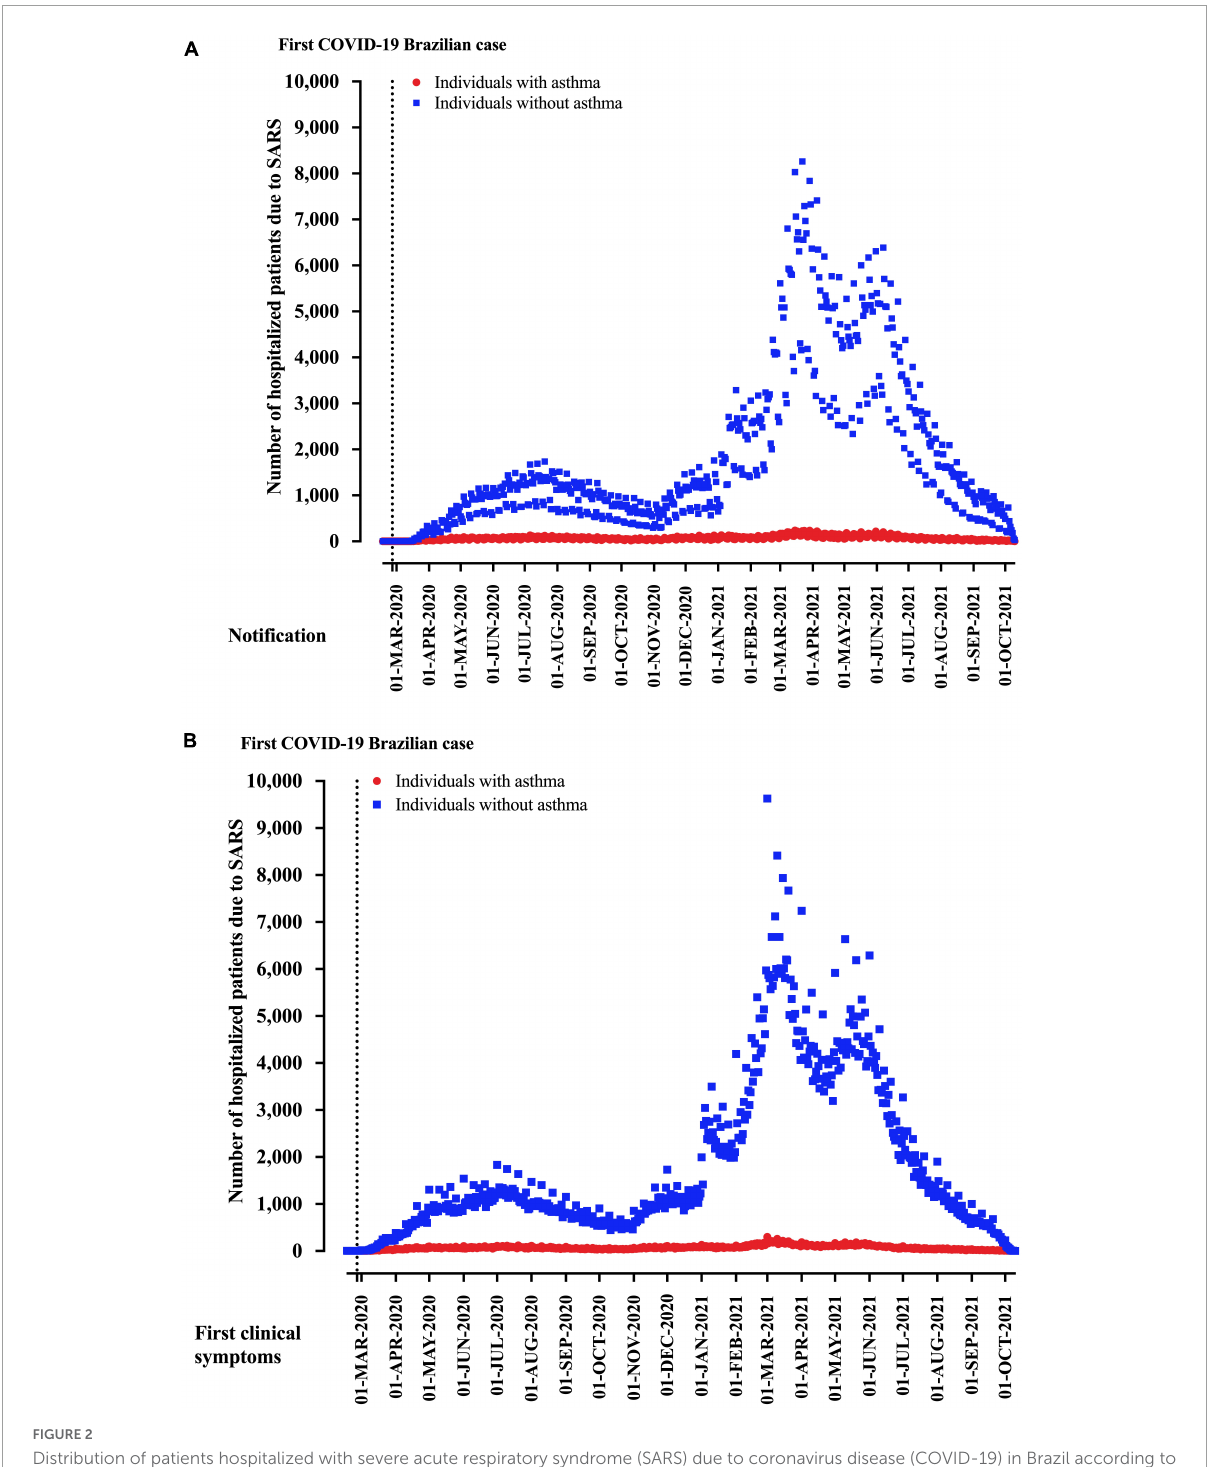
FIGURE2 Distribution of patients hospitalized with severe acute respiratory syndrome (SARS) due to coronavirus disease (COVID-19) in Brazil according to asthma diagnosis. We presented the data distributed according to the (A) weeks of disease notification and (B) start of clinical signs.